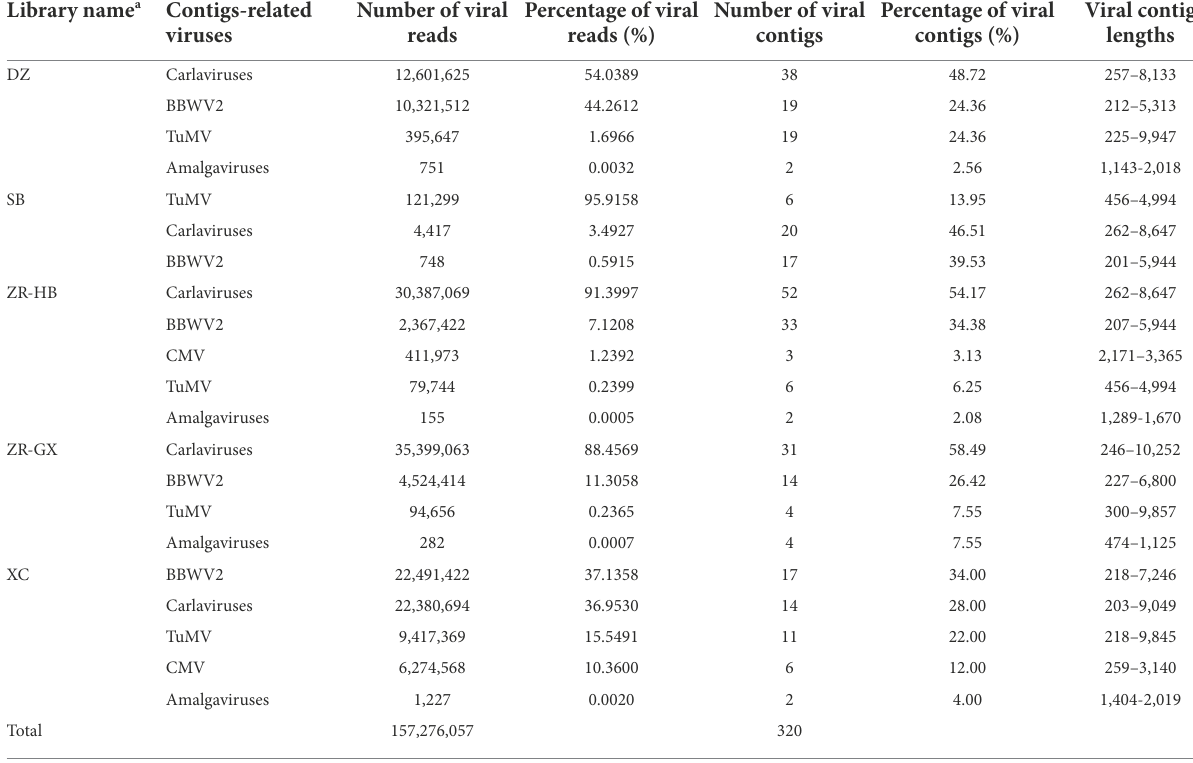
TABLE 1 Information of the viral reads and contigs for the viruses identified in Pseudostellaria heterophylla in China.